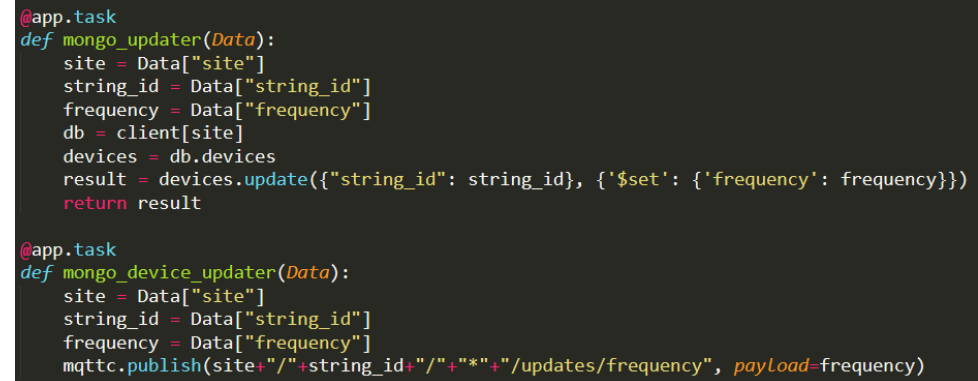
Figure 14. Celery workers updating the string frequency in the database and the physical devices.